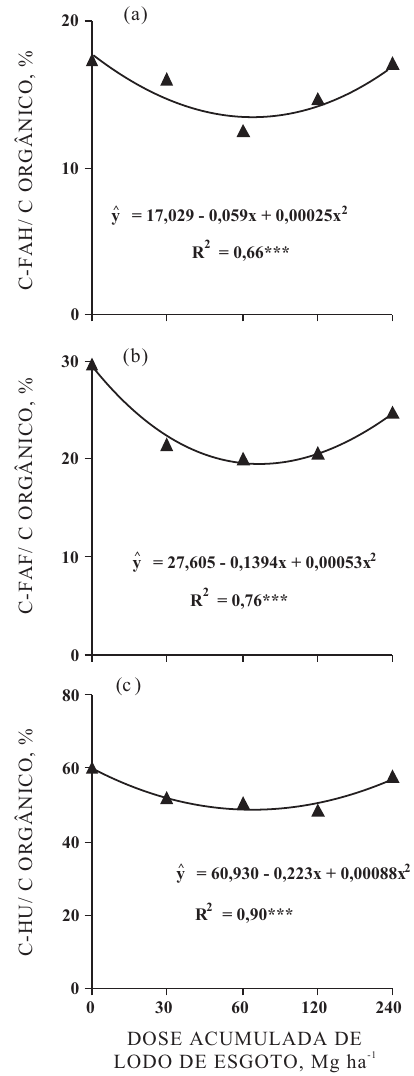
Figura 4. Relação entre as frações ácidos húmicos (a), ácidos fúlvicos (b) e huminas (c) e o carbono orgânico em Latossolo sucessivamente tratado com lodo de esgoto. (***: Significativo a 0,1 %) Quadro 4. Relação entre os teores de carbono na forma de frações ácidos húmicos (C-FAH) e frações ácidos fúlvicos (C-FAF), extrato alcalino (EA) e humina (HU) em Latossolo sucessivamente tratado com doses crescentes de lodo de